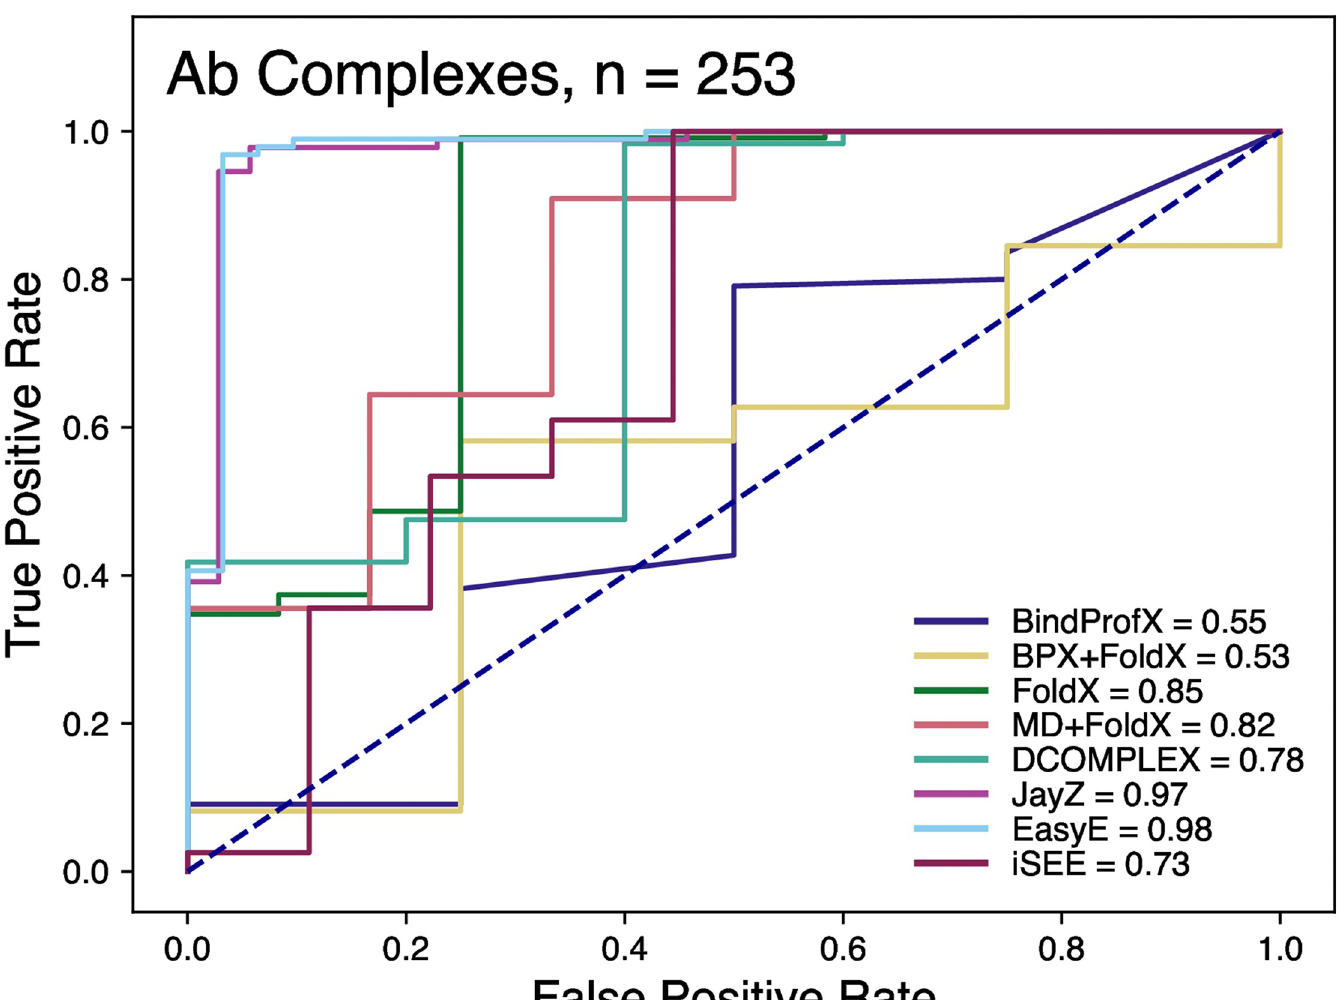
Fig 5. Receiver operating characteristic curves of the classification of variants that are more destabilized or less destabilized than 0.5 kcal/mol. The values in the legend represent the area-under-curve (AUC). The higher the value, the better the prediction capability of the